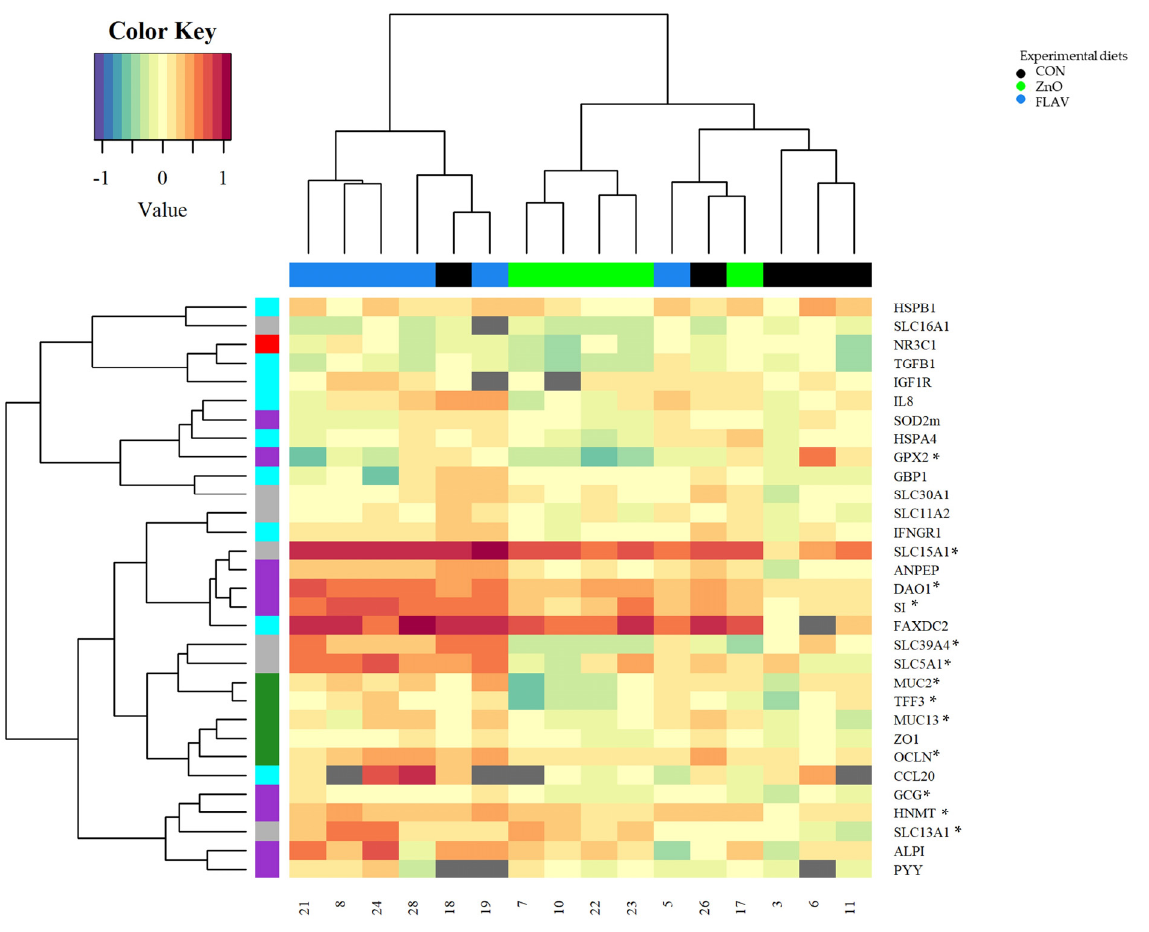
Figure 1. Heatmap and hierarchical clustering of jejunum gene expression levels of pigs fed experi- mental diets. Significant differences are indicated using an asterisk symbol ( p < 0.10). Data are means of 3 pigs at 7d postweaning.